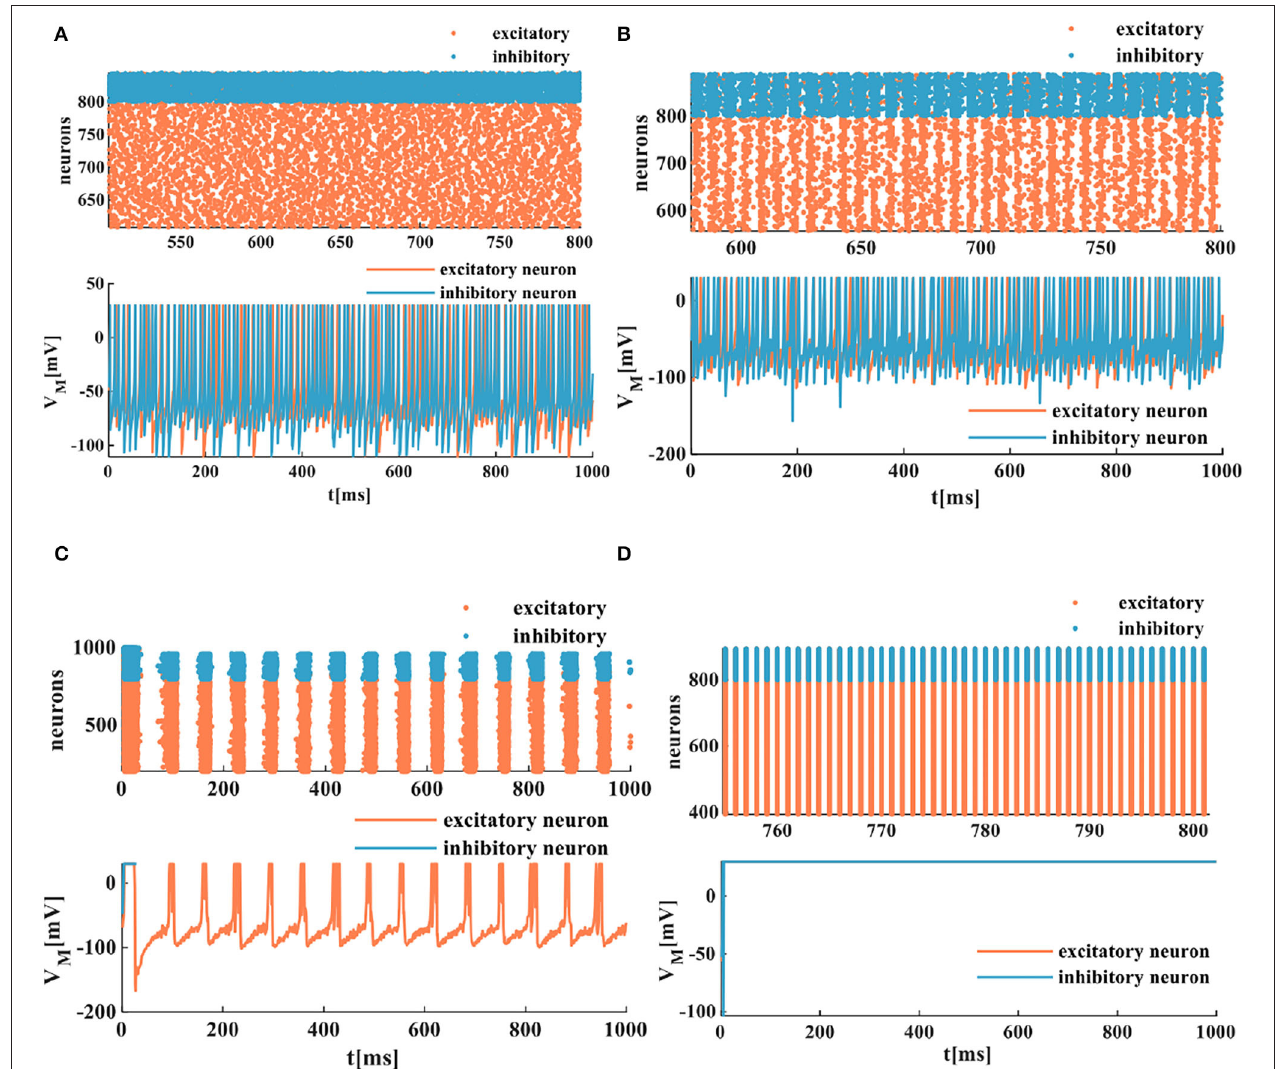
FIGURE 10 | The evolution of the spatiotemporal pattern with the various coupling strength. (A) The neurons of the network in the asynchronous state (an enlarged plot). (B) The network in the asynchronous state with the increased synaptic weight (an enlarged plot). (C) The network in the synchronous status. (D) The network activity in another stable state (an enlarged plot).